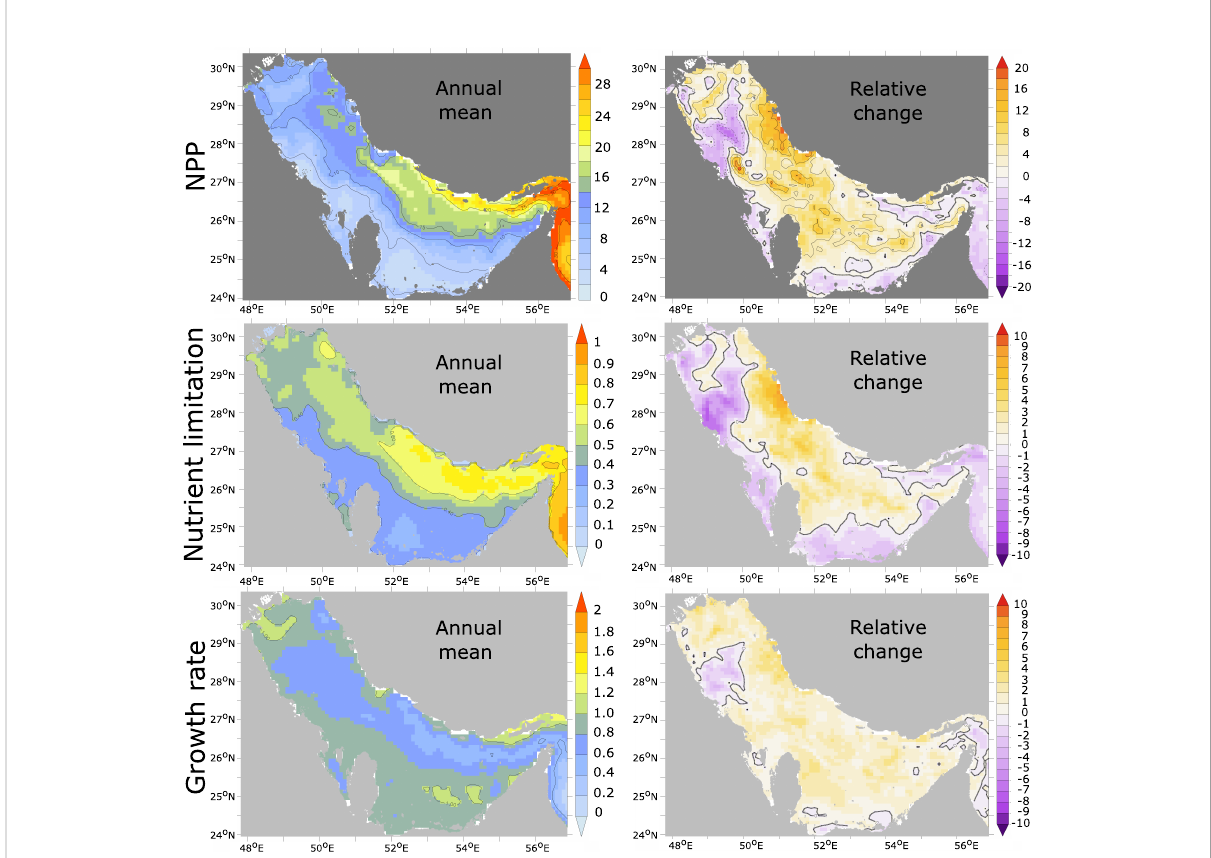
FIGURE 9 Net Primary Production (NPP) changes and its drivers. Net primary production (in mol C m -2 yr -1 ) (top), nutrient limitation factor g ( g (NO − 3 , NO + 4 a non-dimensional factor parameterized using Michaelis-Menten equation that varies between 0 (nutrient-depleted conditions) and 1 (nutrient- replete conditions)) (middle) and the temperature-dependent, light-limited phytoplankton growth rate (day -1 ) under nutrient replete conditions (bottom) in the early 1980s (left) and relative change (in %) between the early 1980s and the late 2000s